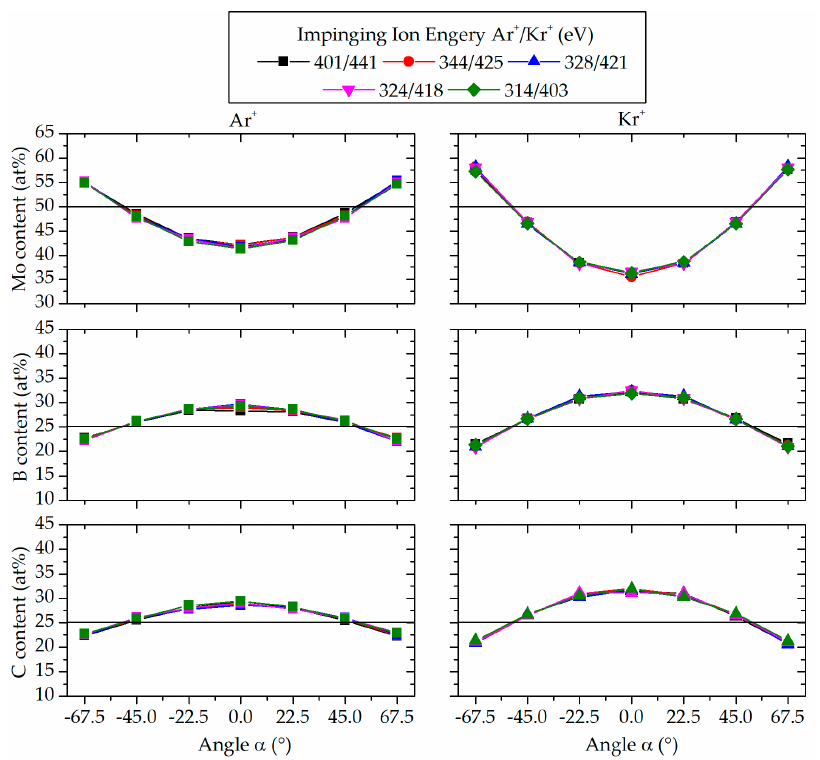
Figure 6. Angle-resolved composition evolution of the sputtered flux for different impinging ion energies of Ar + ( left ) and Kr + ( right ) ions. The first energy value pertains to Ar + sputtering, the second value to Kr + sputtering. The ideal stoichiometric target composition is marked by the black horizontal lines.